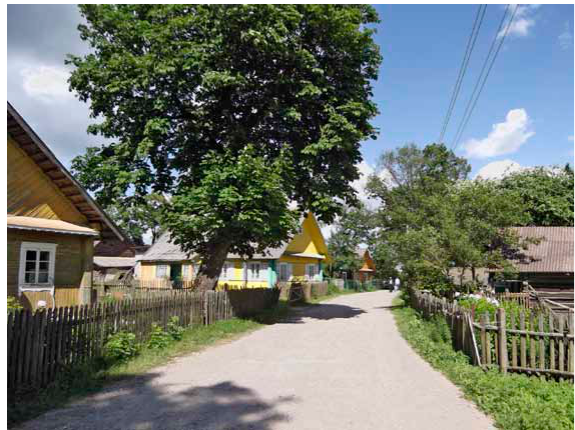
fig. 22. The street perspective of the old Valakas type village whose street arrangement create spatial comfort and aesthe- tic appeal (the Žižmai village in the Šalčininkai district munici- pality). I. Povilaitienė photo